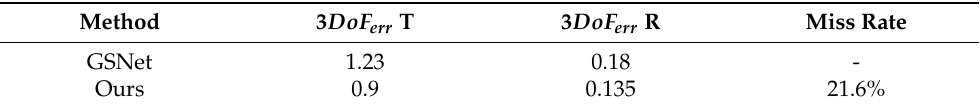
Table 2. 6 DoF error comparison.